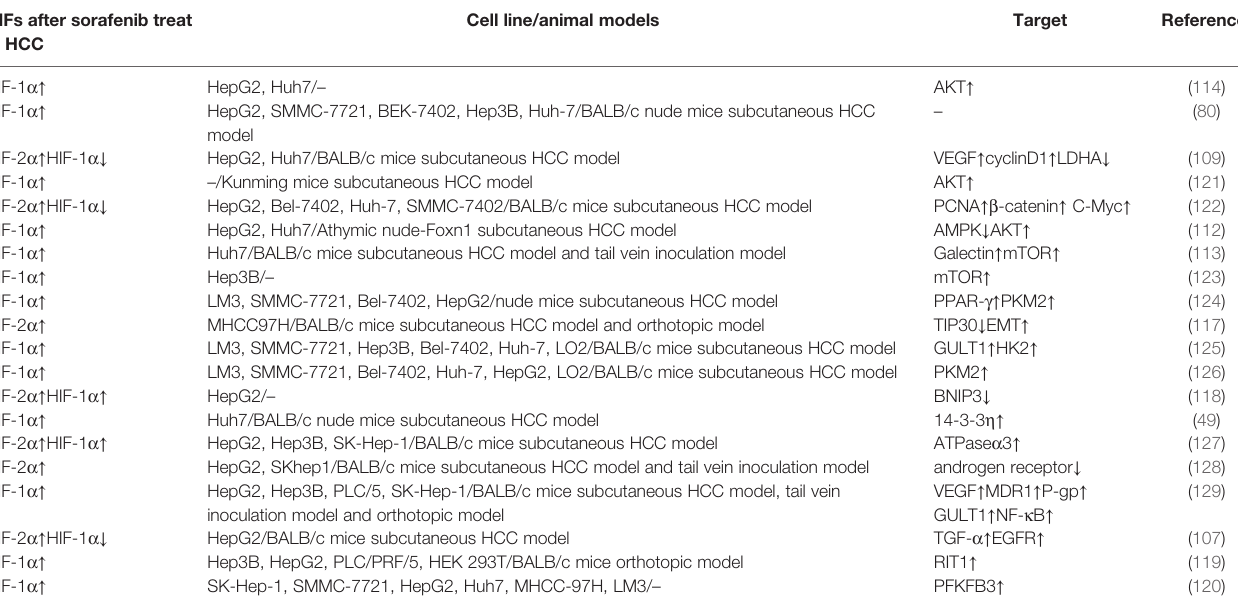
TABLE 3 | Hypoxia and sorafenib resistance in HCC